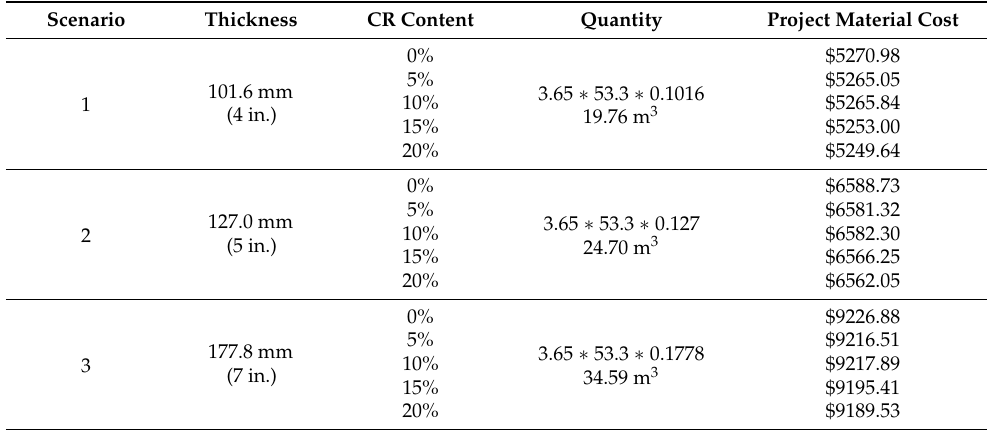
Table 4. Quantity and cost of concrete mixtures required for different TWT